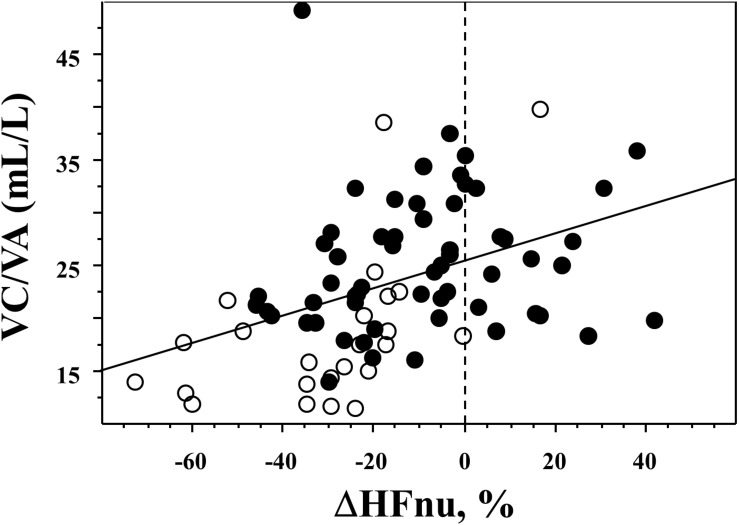
Relationship between the effect of paced ventilation and VC/VA. A significant correlation was evidenced between VC/VA and ΔHFnu: R = 0.406, p = 0.0002. Black circles are SDC children while open circles are asthmatic non-SCD children.